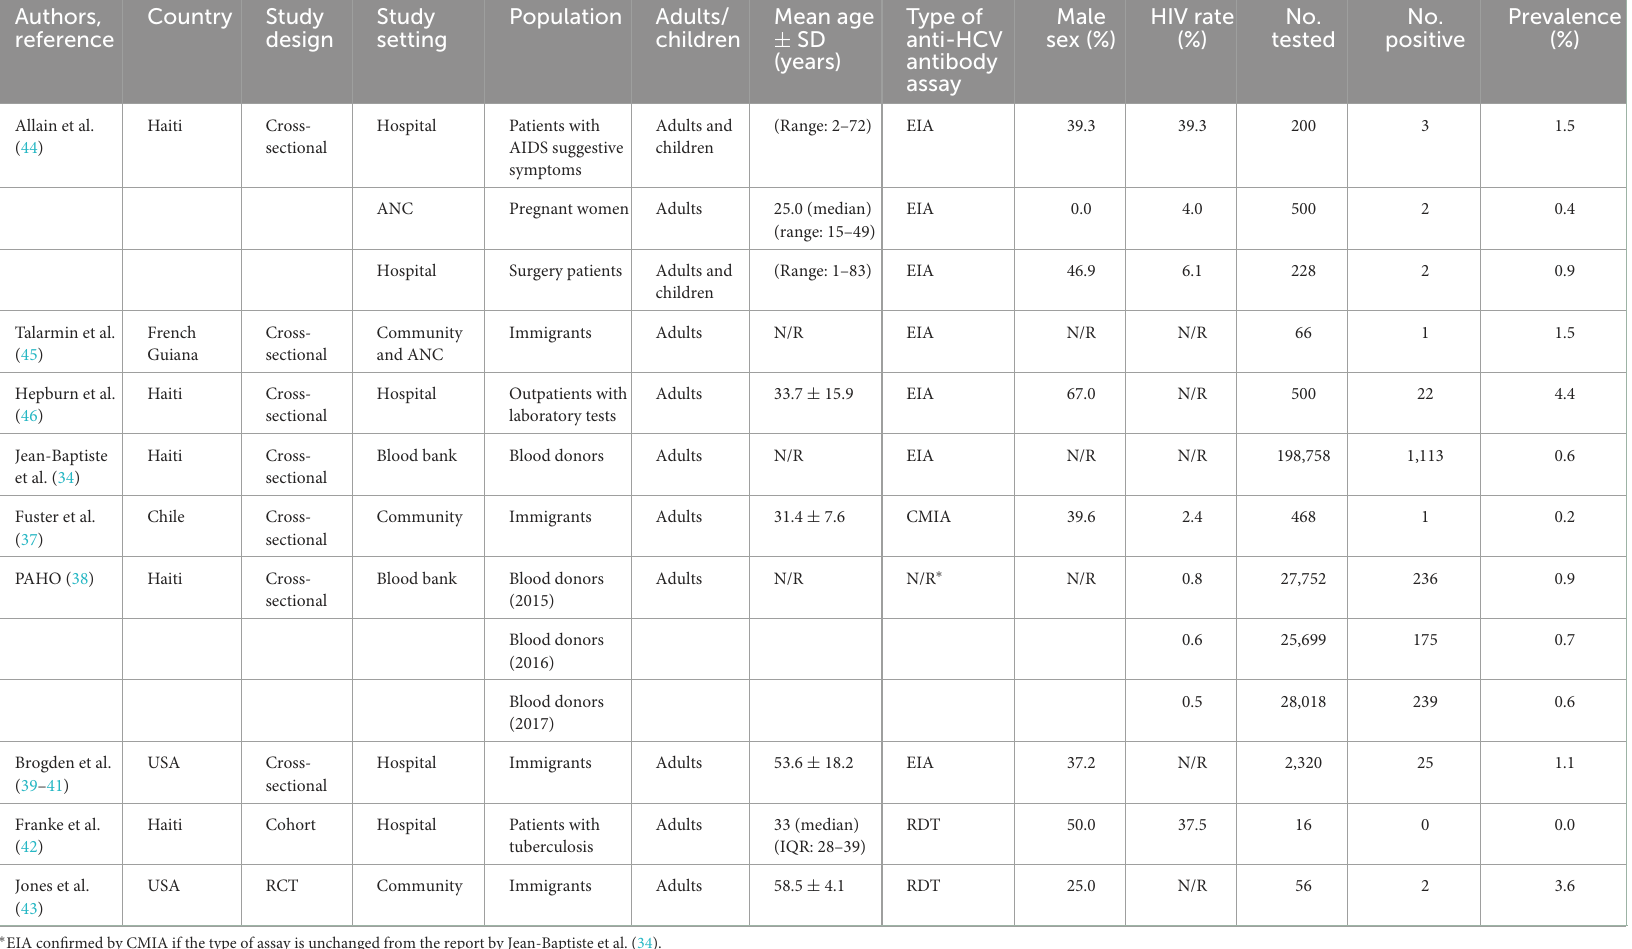
TABLE 2 Studies reporting the prevalence of anti-HCV antibody among